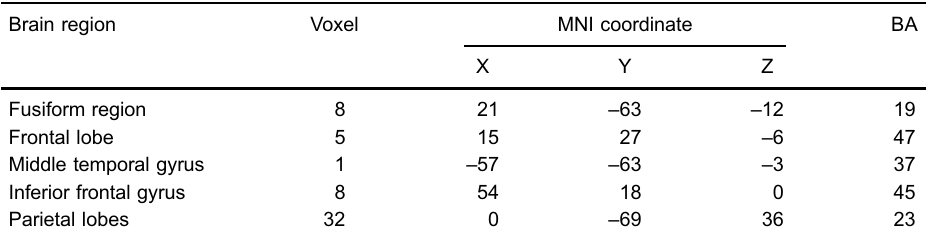
Table 1. Regions of the brain with decreased regional homogeneity (ReHo) values in amnestic mild cognitive impairment patients compared with the normal elderlies